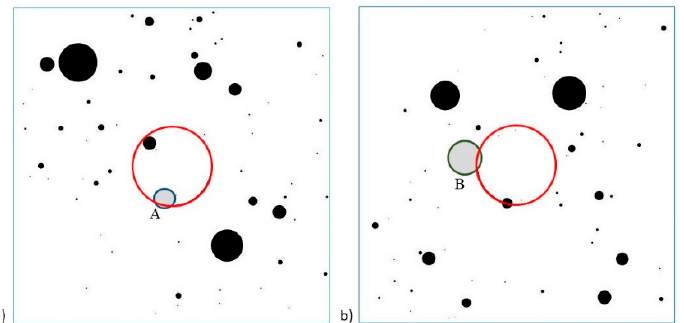
Figure 4. Two tunnel configurations with a protruding boulder (in light gray). ( a ) The protruding block A has an intersection area greater than the threshold value. Hence, the code classifies it as a possible cause of obstruction. ( b ) The protruding block B has an intersection area smaller than the threshold value. Since it does not represent a possible cause of obstruction or other technical problems, the code discards it.